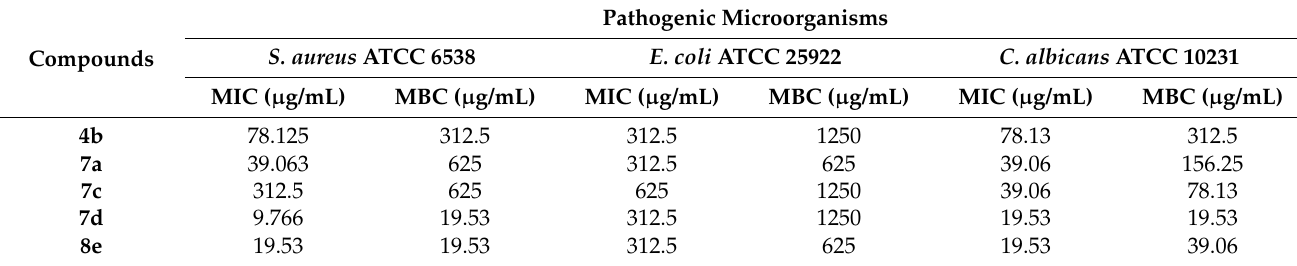
Table 2. The minimum inhibitory concentrations (MICs), and minimum bactericidal concentrations (MBCs) of the most active selected compounds. Pathogenic Microorganisms S. aureus ATCC Compounds